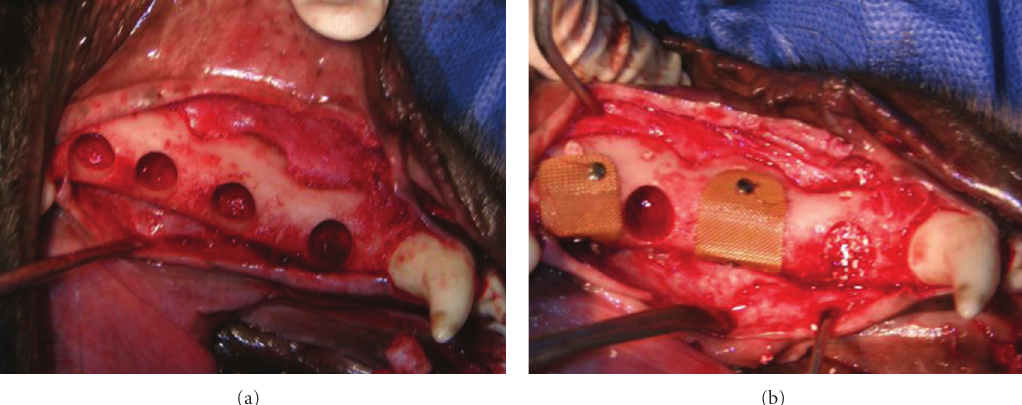
Figure 1: (a) Four cylindrical defects, 6mm deep and 6 mm in diameter, were prepared on each side of the mandible. (b) The four types of treated